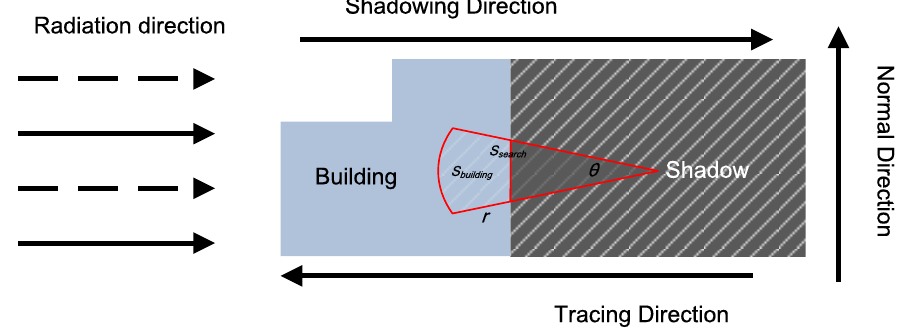
Figure 2. The principle of the shadowing